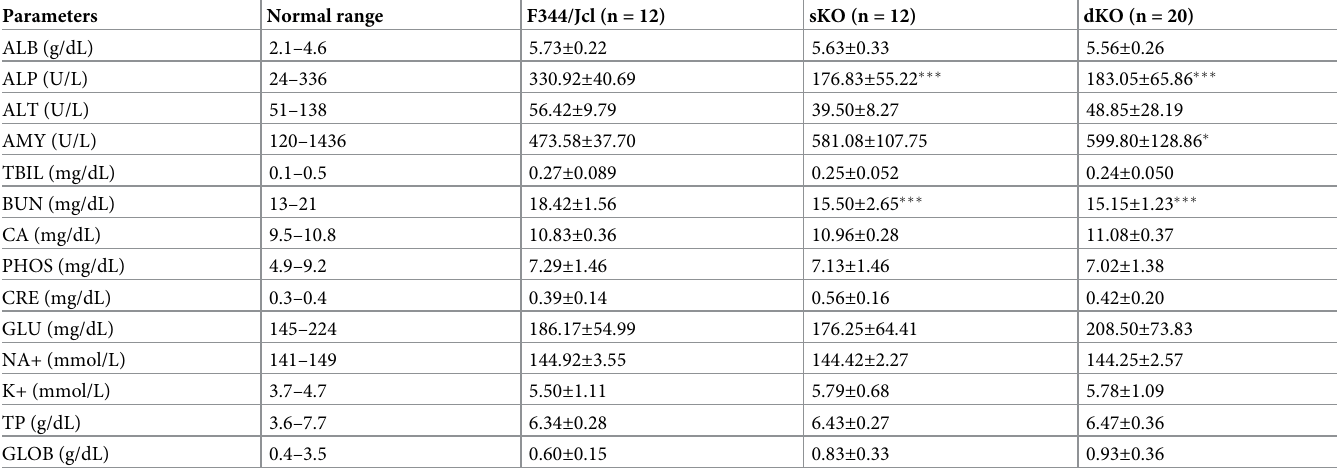
Whole blood from adult rats was